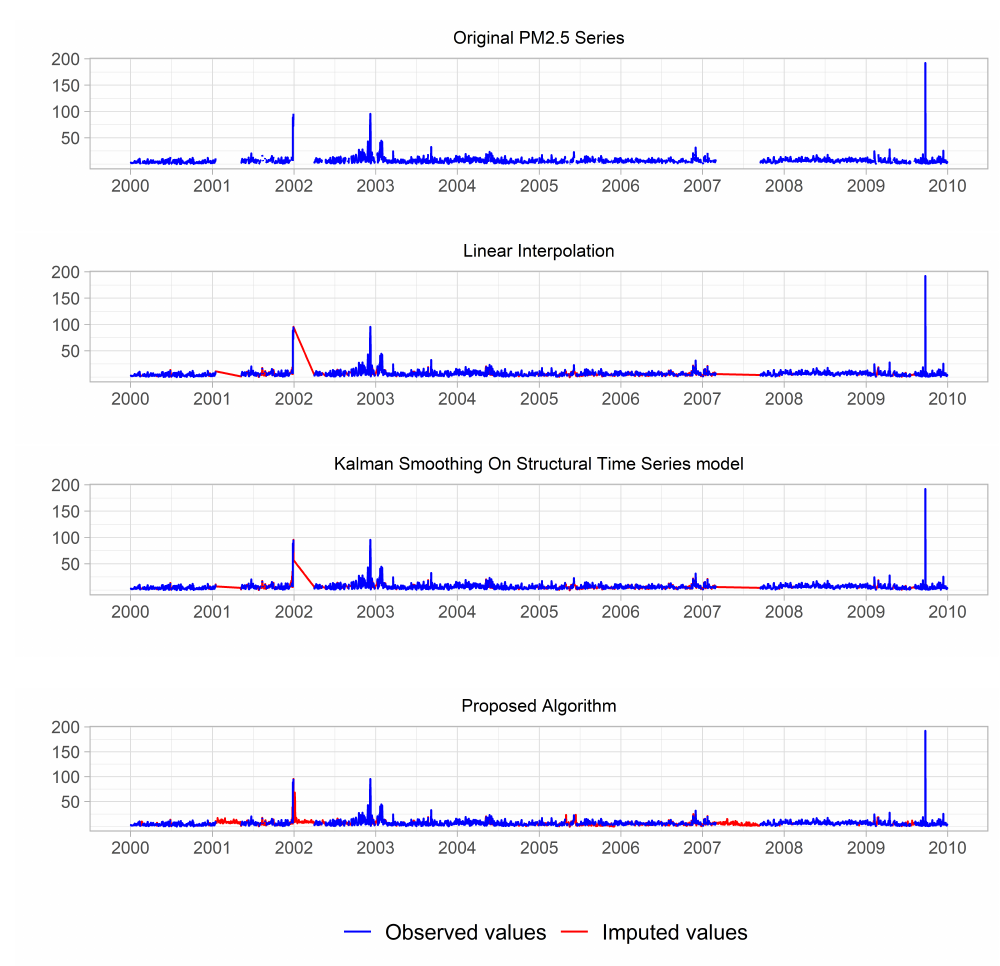
Figure 7. Visual comparison of the imputed values for a large gap using Linear interpolation, Kalman Smoothing On Structural Time Series model and the proposed